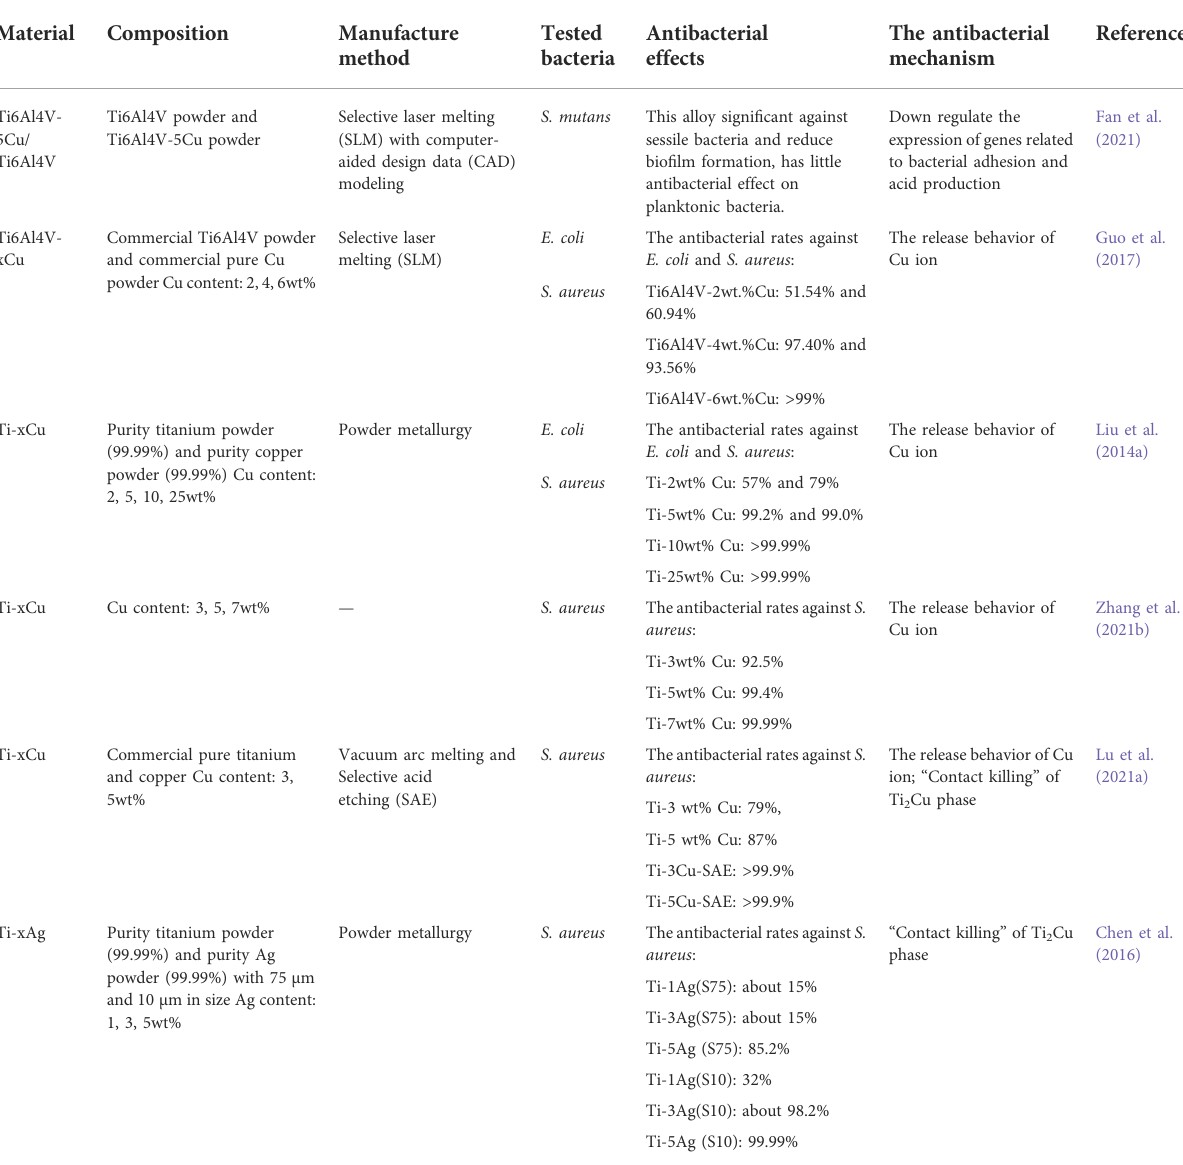
TABLE 1 Summary of various alloys containing antibacterial